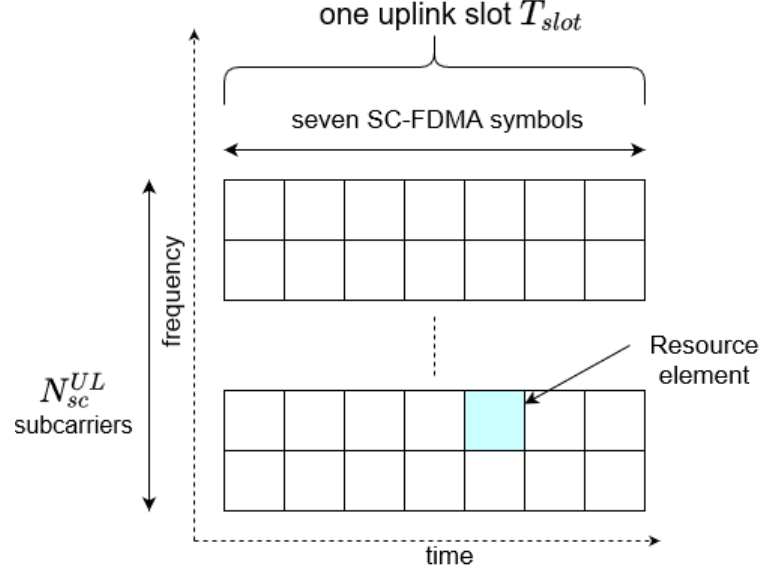
Figure 5. NB-IoT resource grid